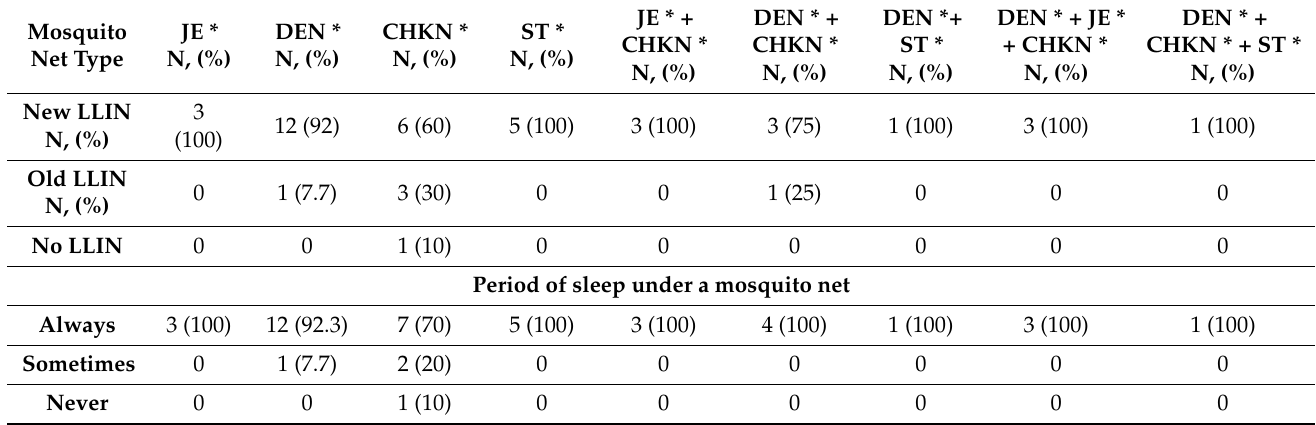
Table 3. LLIN coverage and compliance pattern among tested and positive cases from villages. N denotes no. of persons, % in parenthesis represents LLINs use under different net categories.